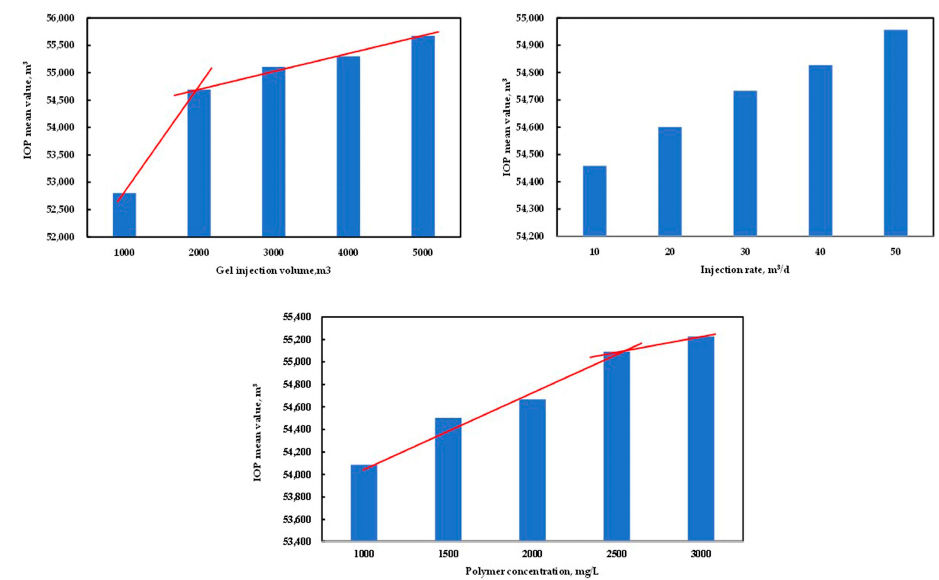
Table 8. The IOP mean value of different parameters and its range. Figure 16. The IOP mean value of the gel injection volume, the injection rate, and the polymer concentration.